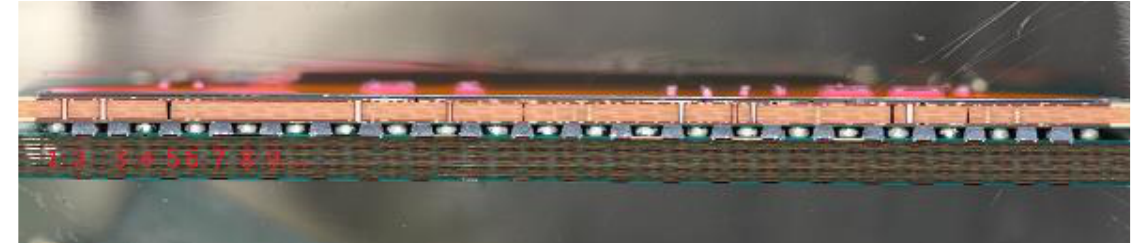
Figure 13. Cross-section of the package.